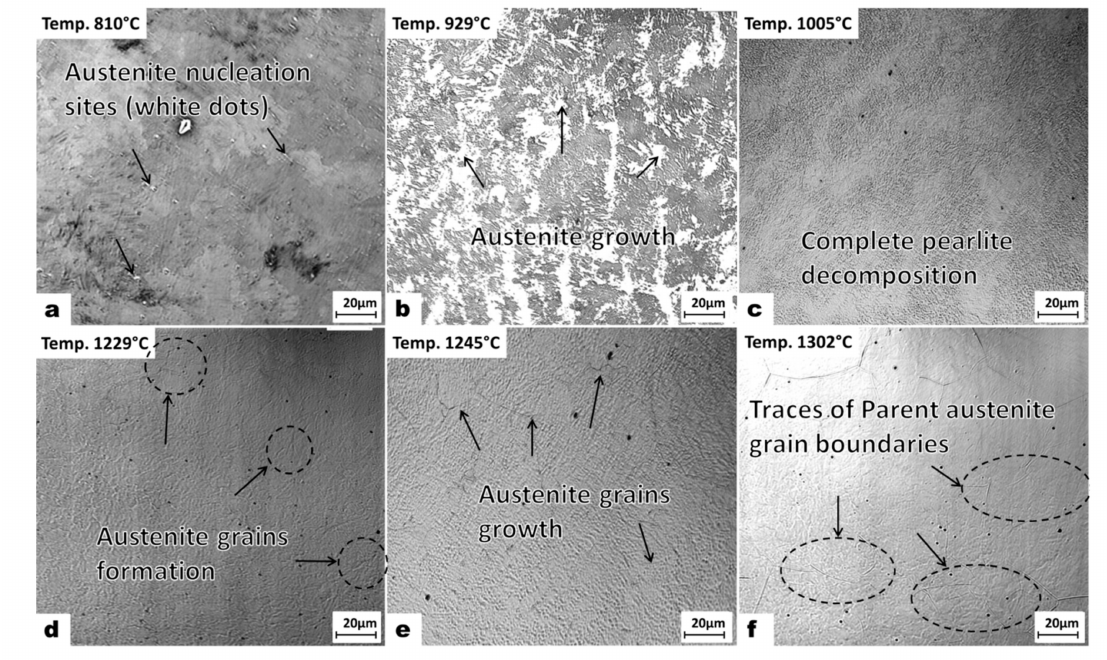
Figure 3. CSLM micrographs at various temperatures under heating stage; from ( a – f )